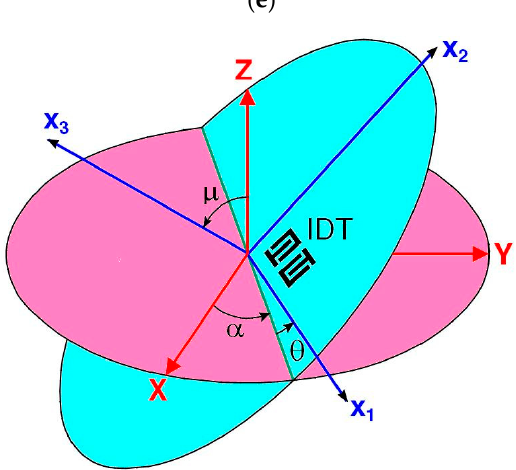
Figure 1. Isolines of SAW parameters as a function of two Euler angles μ and θ in KTP: ( a ) phase velocity (m/s); ( b ) K 2 /2 (%); ( c ) power deflection angle ϕ (degrees); ( d ) TCD (ppm/°C); and ( e ) de- termining the Euler angle ( α , μ , θ ) rotation of the Cartesian coordinate system (x 1 ,x 2 ,x 3 ) from the initial crystallophysic orthogonal coordinate axes (X, Y, Z) of the crystal. For Euler angles (0,0,0), the Cartesian coordinate system (x 1 ,x 2 ,x 3 ) coincides with the crystallophysic orthogonal coordinate axes (X, Y, Z) of the crystal.